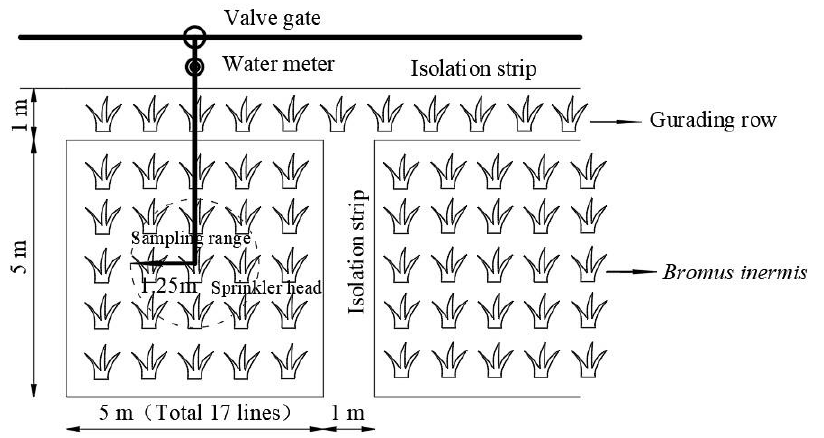
Figure 2. Layout plan of experimental plot.